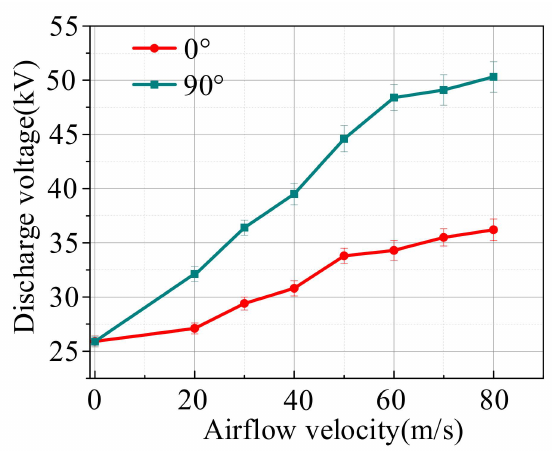
Figure 3. The variation law of the insulation medium discharge voltage along the surface with the airflow speed under different airflow